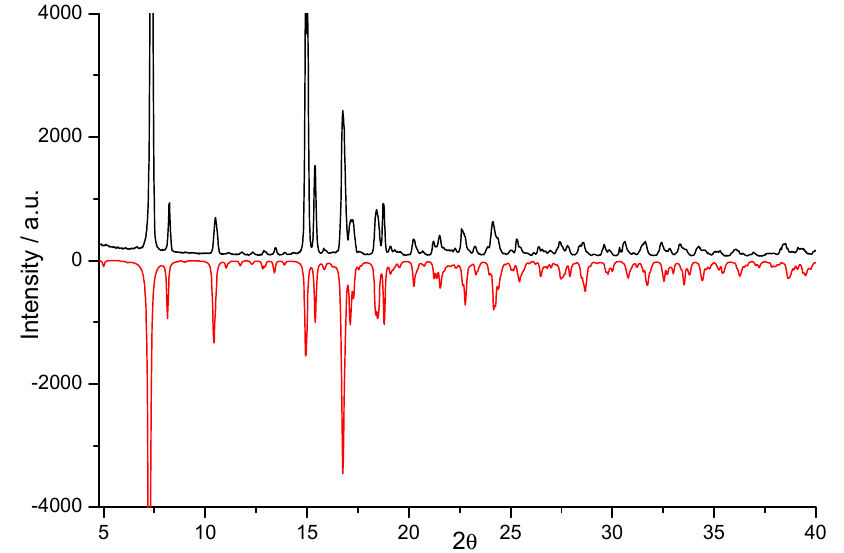
Figure 3. Calculated from the single-crystal diffraction data (red) and experimental powder XRD (black) diffractograms for 1 .